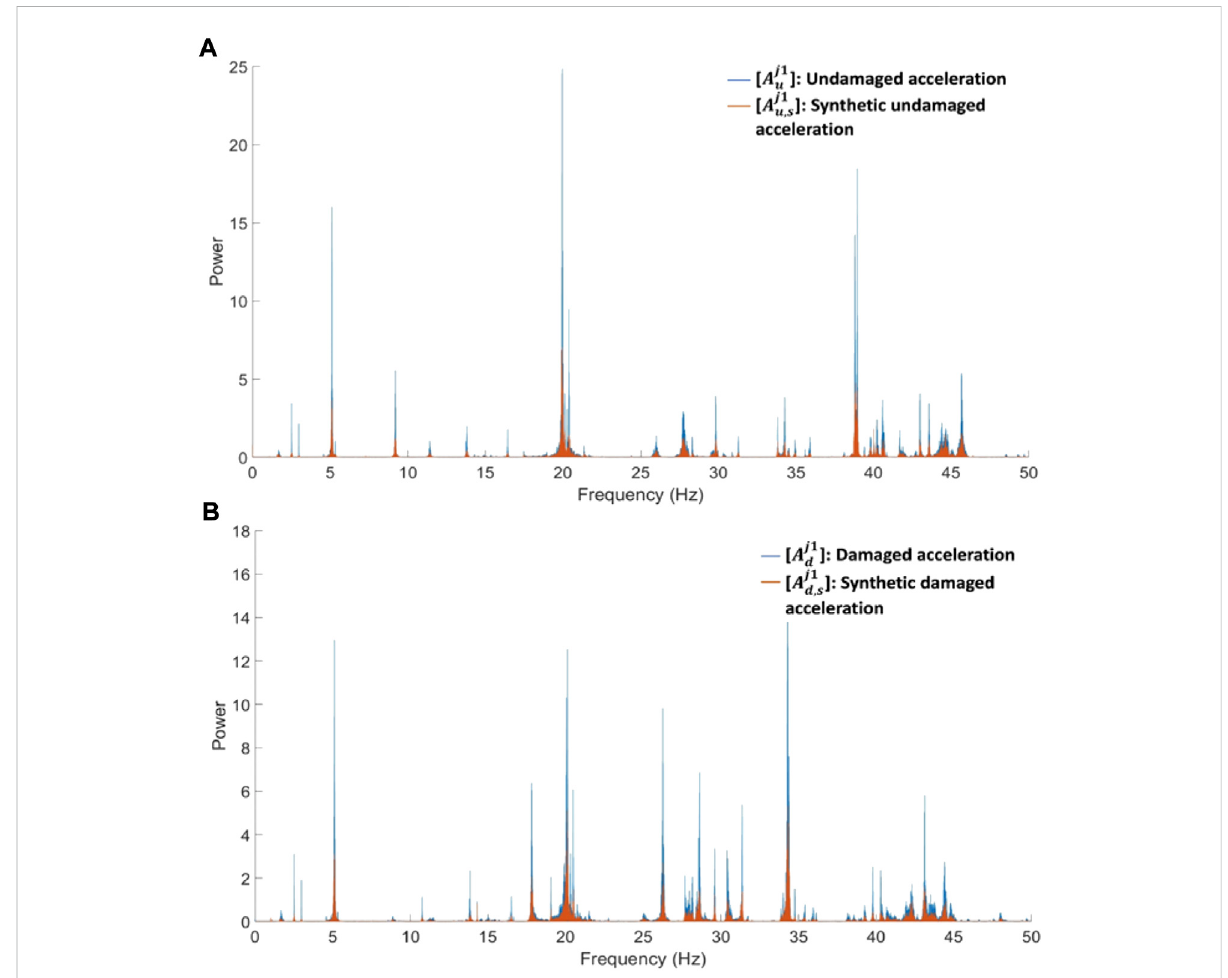
FIGURE 13 (A) Frequency domains of real and synthetic (translated from damaged) undamaged acceleration response signal at joint 1, (B) Frequency domains of real and synthetic (translated from undamaged) damaged acceleration response signal at Joint 1 (Luleci et al.,